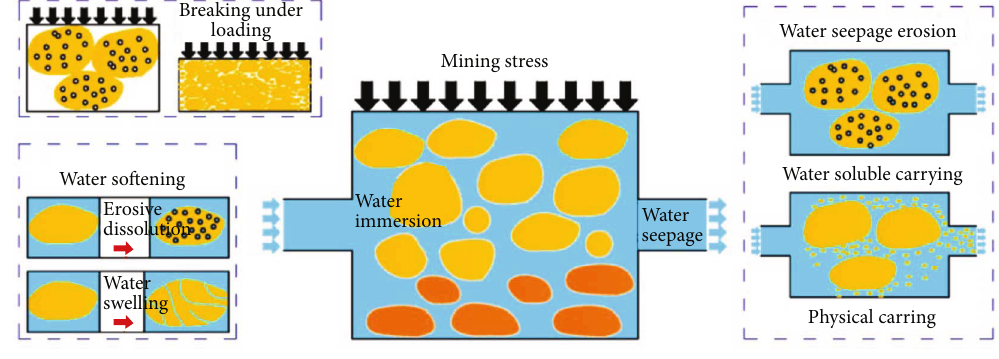
Figure 11: Mine water seepage in broken rock mass